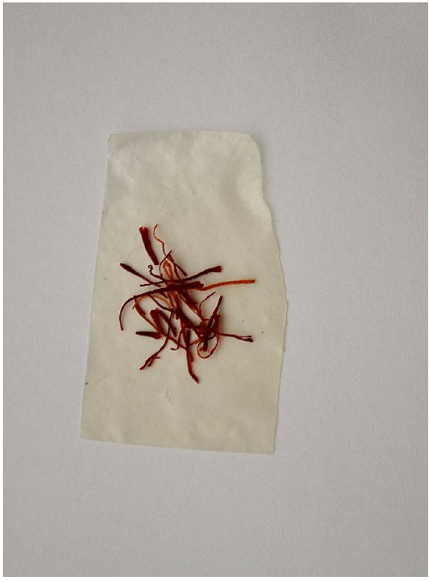
Figure 2. Packaging of the saffron with the nanocomposite CNC film.